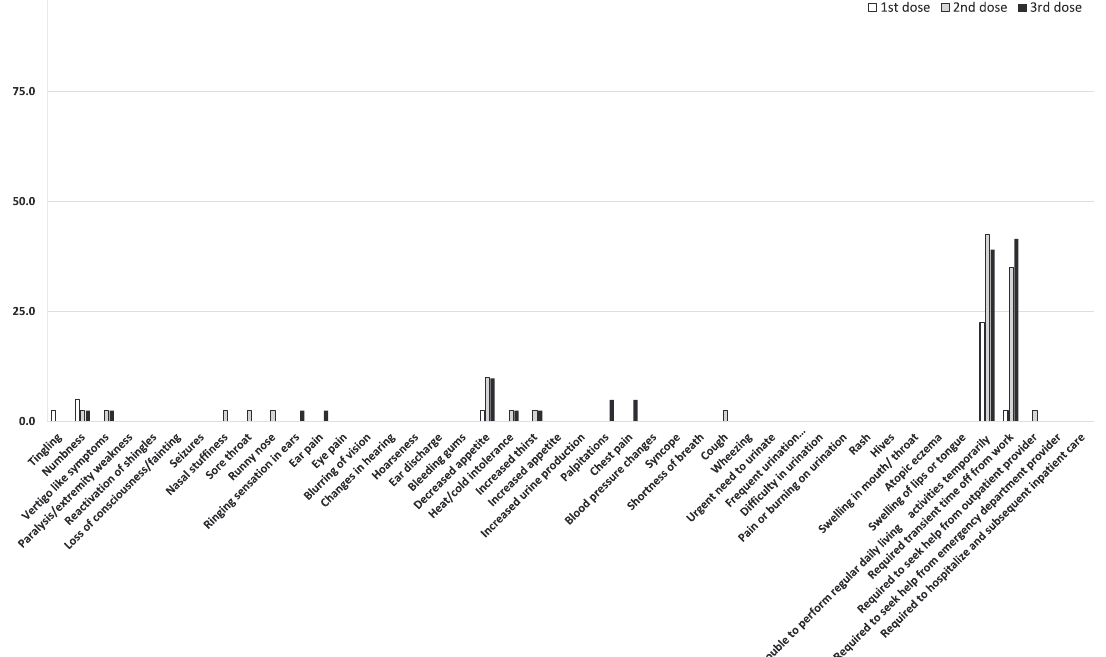
Figure3: Summary of the side effects of theBNT162b2 vaccineafter thefirst (whitebars), second (graybars) and third(black bars) doses of the